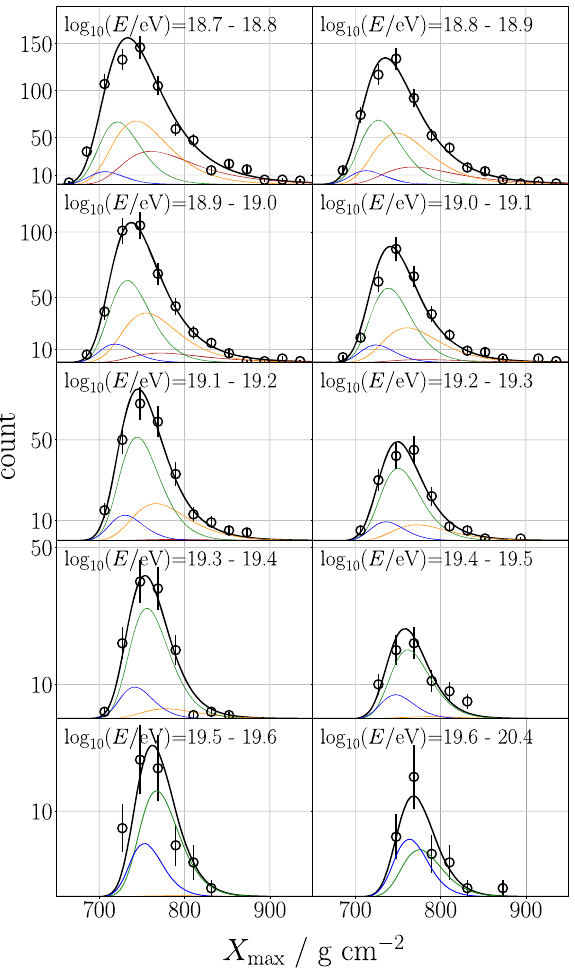
Fig. 3 Depth of the shower maximum X max distributions in energy bins. The binning is the same as for the energy spectrum with a com- bined bin above 10 19 . 6 eV due to the smaller statistics. The benchmark simulation with O ( 2 , 700 ) events containing an X max value is shown as symbols with Poissonian errors. The curves refer to the reweighted distributions from the propagation database, scaled to the same number of cosmic rays. The contributions by the different element groups are color-coded as in Fig.